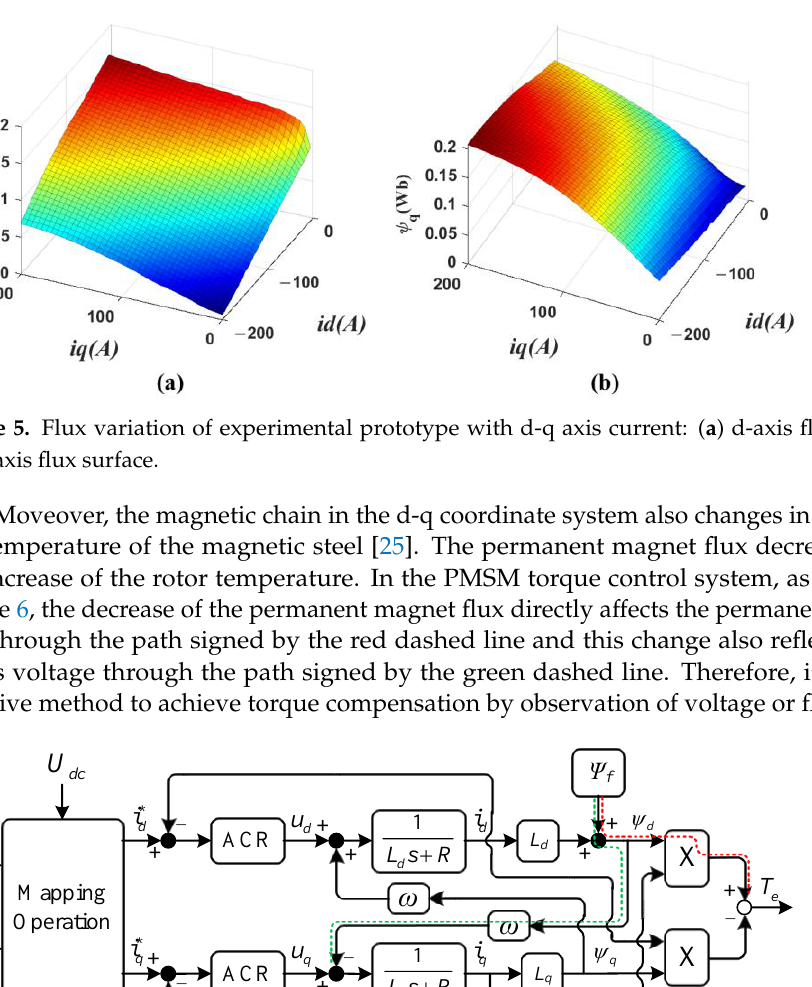
Figure 6. Influence of permanent magnet flux change on torque control system.